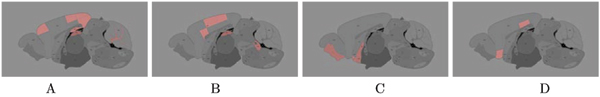
Enrichment for GO terms. Regions enriched (p-value < 0.01) for expression of genes involved A. sensory perception of sound (GO:0007605), B. learning and memory (GO:0007611), C. feeding behavior (GO:0007631), and D. visual learning (GO:0008542).